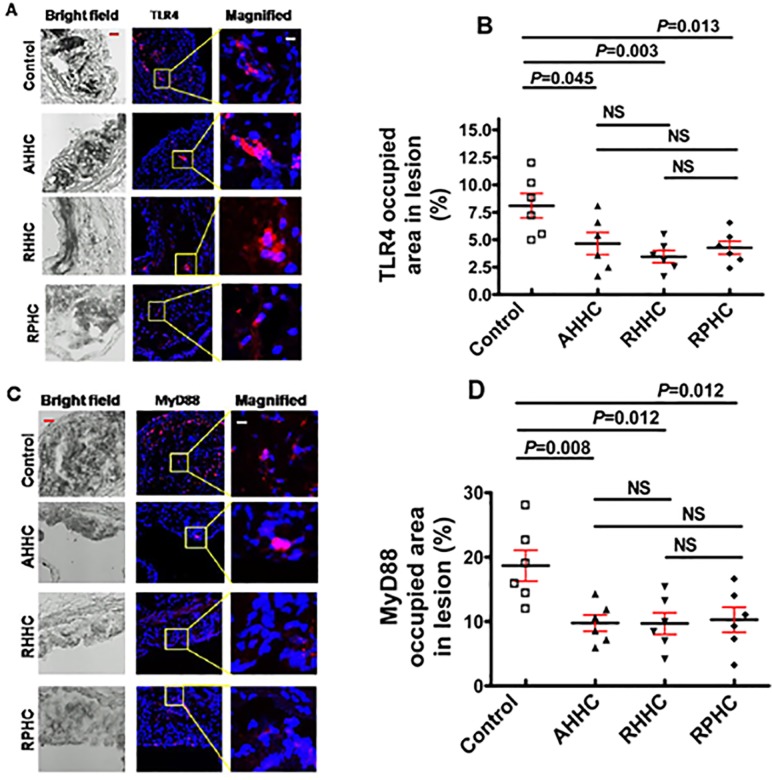
Evaluation of the content of TLR4 and MyD88 contents at the lesion sites.(A) Photomicrographs showing IHC staining for TLR4 (red) (scale bar: 100 μm and 12.5μm for magnified ones). (B) Scatter plot showing means of anti-TLR4-stained area (N = 6). (C) Photomicrographs showing IHC staining for MyD88 (red) (scale bar: 100 μm and 12.5μm for magnified ones). (D) Scatter plot showing means of anti-MyD88-stained area (N = 6).